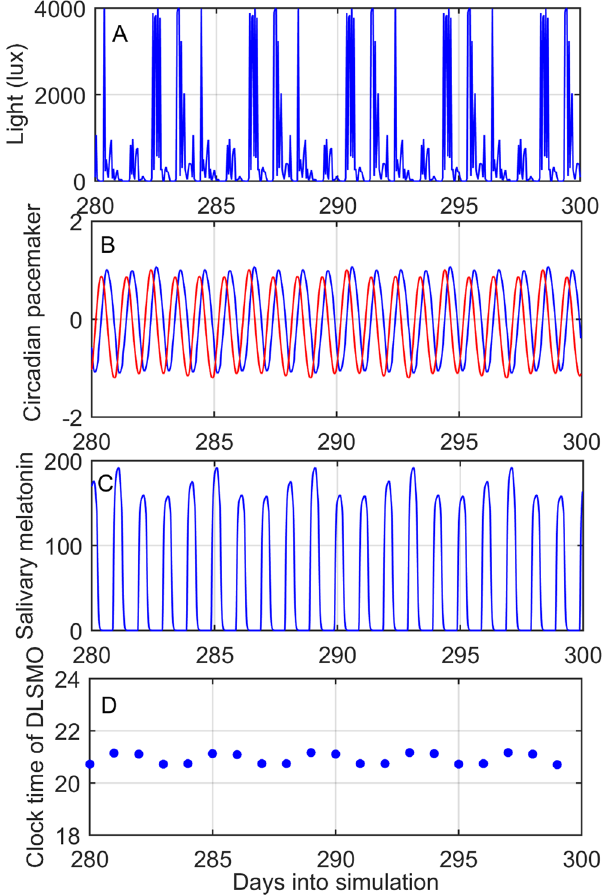
Figure 4. Example of model inputs and outputs for one participant. Variables are shown for days 280–300 of a 300-day simulation for one participant from the Regular group. ( A ) Binned light levels in lux. ( B ) The two circadian pacemaker variables, x (blue) and x c (red). ( C ) The predicted salivary melatonin concentration. ( D ) The clock-time of Dim Light Salivary Melatonin Onset (DLSMO) on each